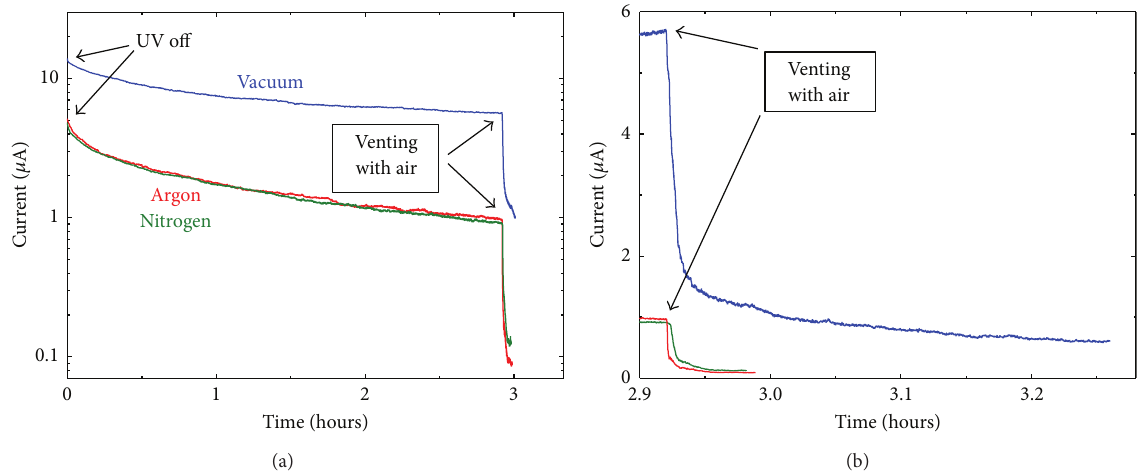
Figure 4: Photocurrent decay of a single ZnO nanowire device after removing the UV excitation, in vacuum and inert gas atmospheres; (b) shows a magnification of (a), when air is introduced into the chamber. The decay rate increases considerably.